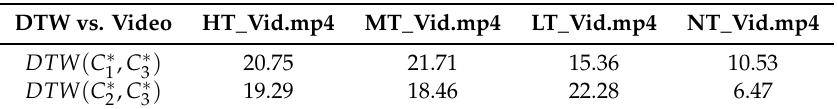
Table A2. Omnidirectional Traffic Curve Comparison: C ∗ Human Count (ground truth); the video frame size was 640 × 480, the interrogation window size was 90; and the interrogation window overlap was 60%